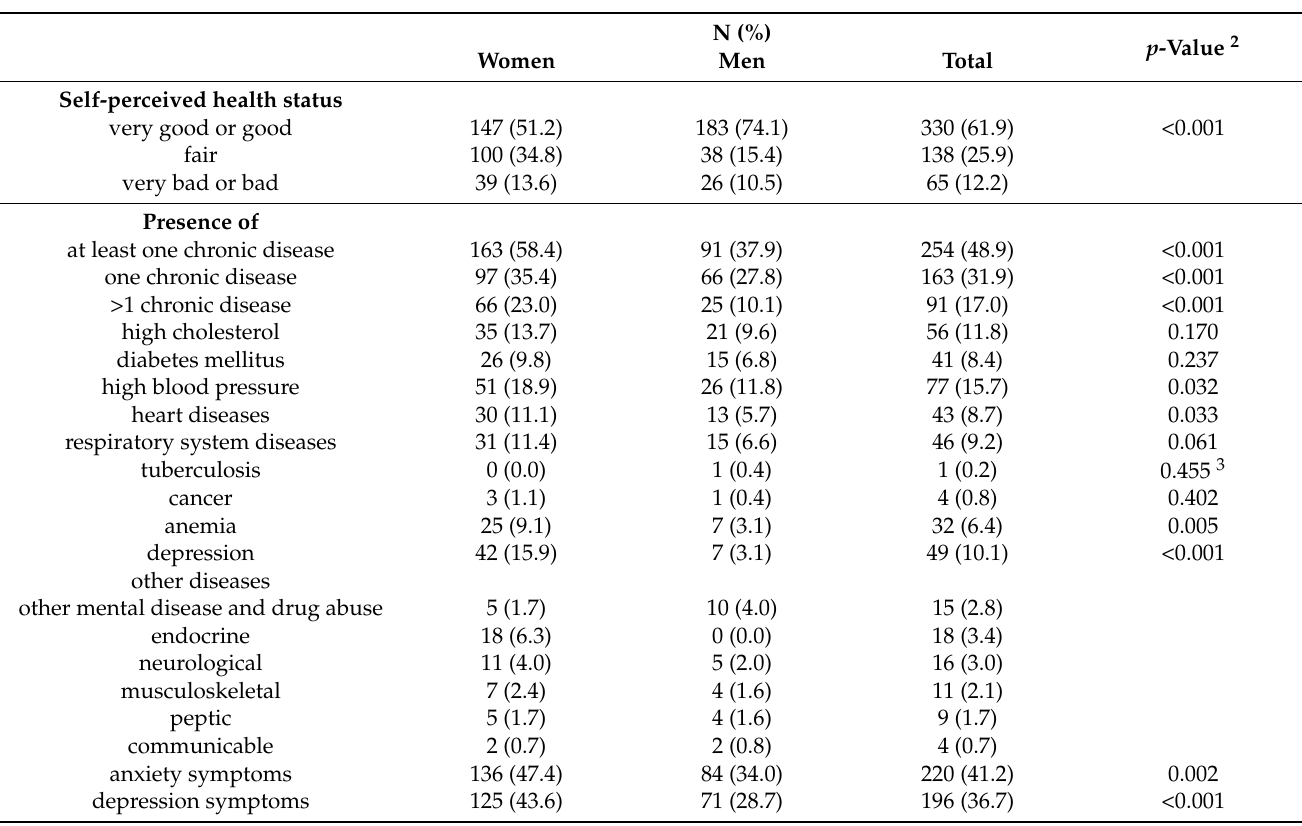
Table 2. Self-perceived health status, the presence of chronic diseases, and anxiety and depression symptoms of Roma living in Roma settlements in Greece by